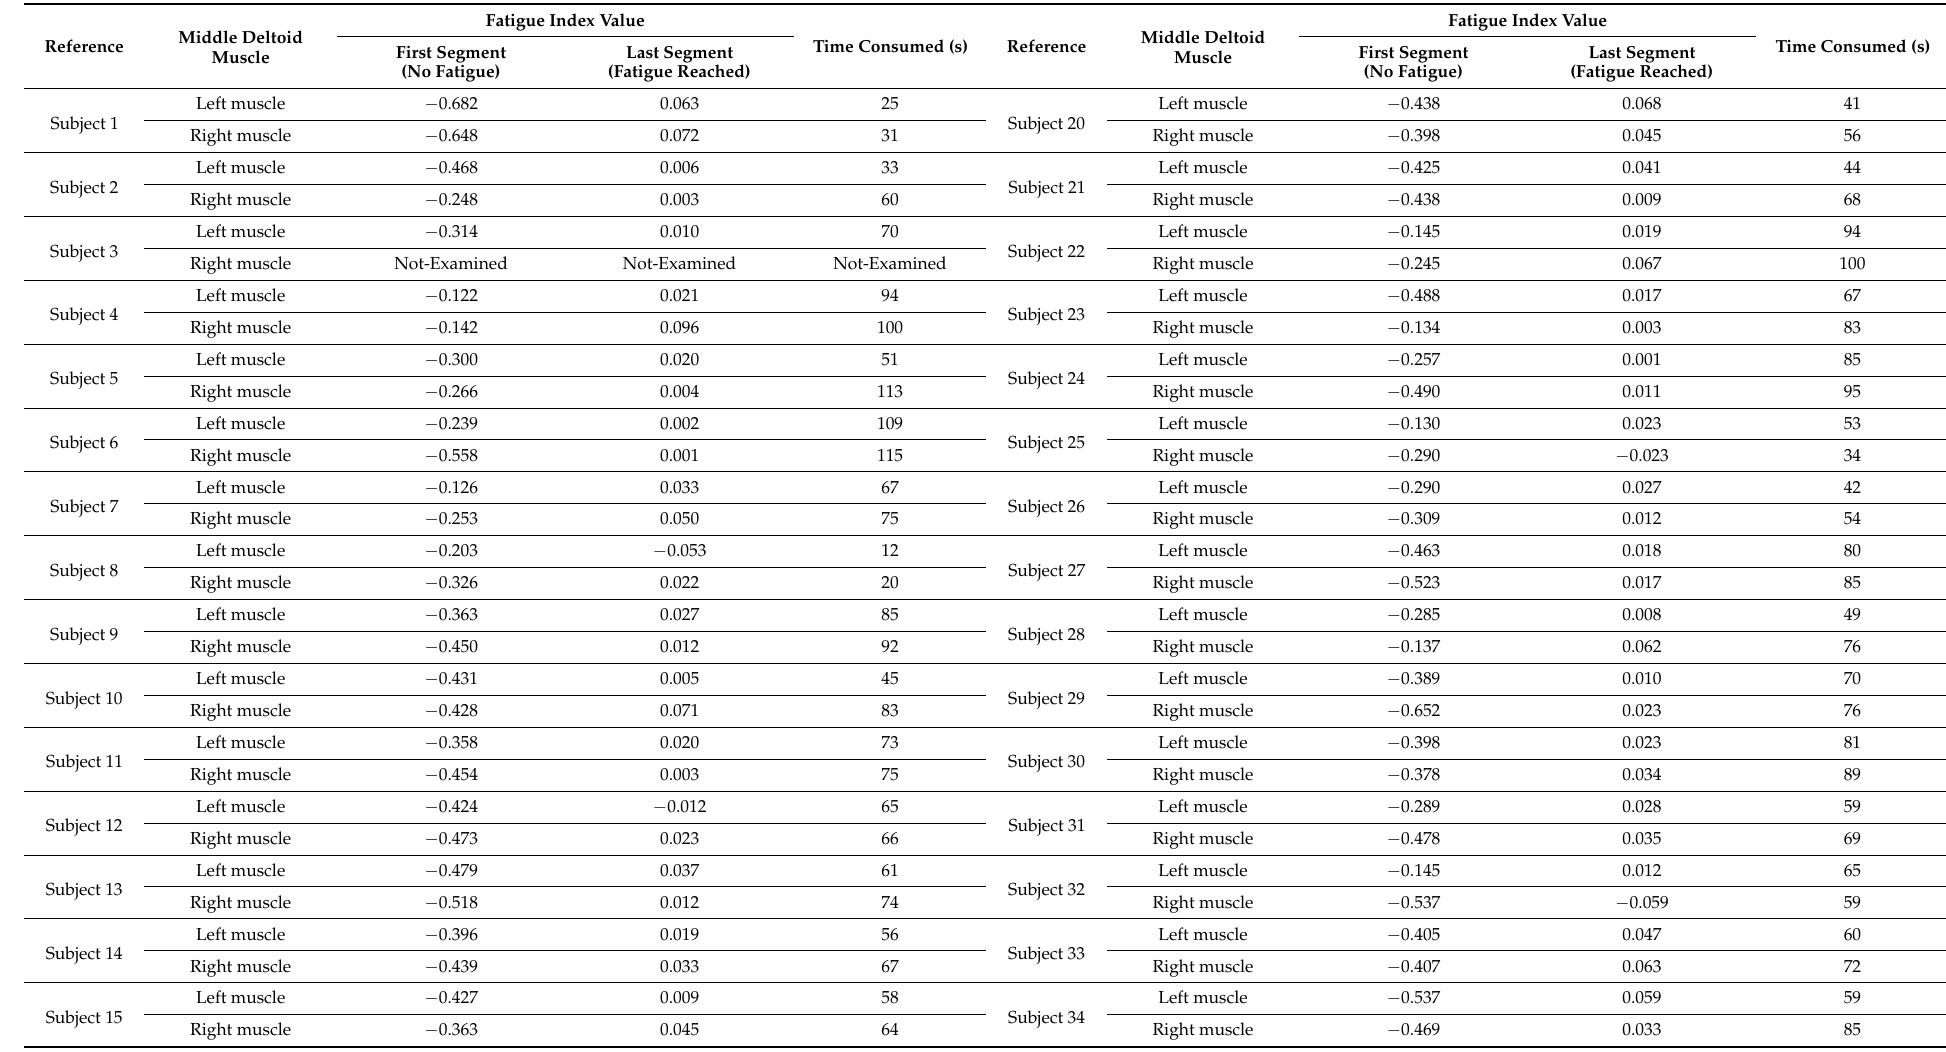
Table 5. Fatigue indices in fatigue